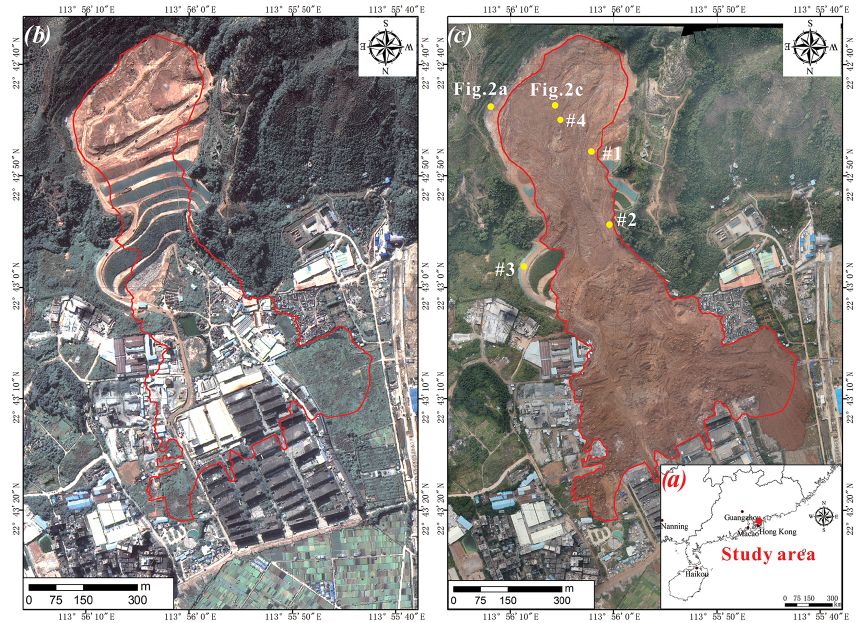
Figure 1. Location of the study site and images of the pre-/post-failure dumpsite. The boundary of the flowslide is indicated in red. (a) Location of the study area; (b) Pléiades satellite image (18 December 2015); (c) aerial photo with DEM of the flowslide with locations of samples for laboratory tests (23 December 2015).